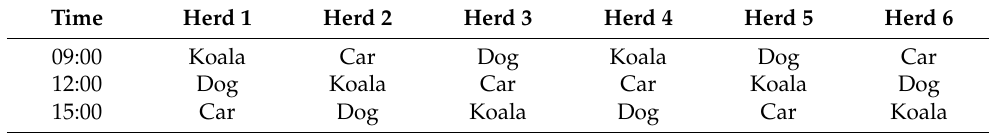
Table 3. Balanced Latin Square design of treatment sequence across the six herds of each cattle class. Time Herd 1 Herd